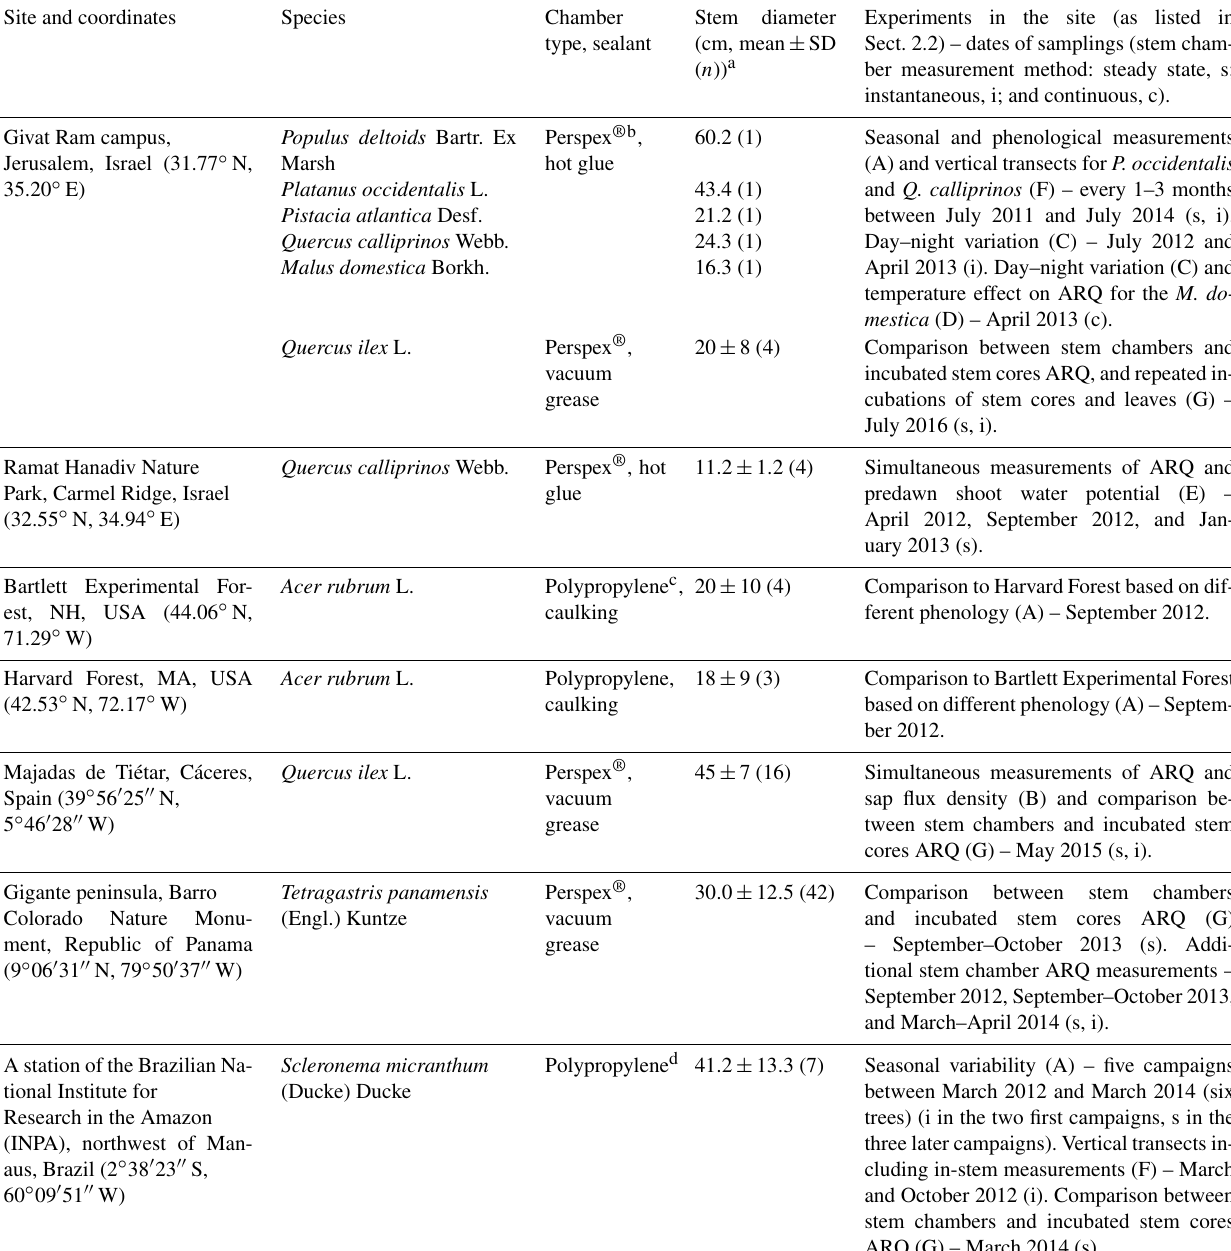
Table 1. Study sites, tree species sampled at each site, stem chambers, stems diameters, and experiments done in the site (A–G list in Sect.